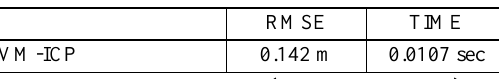
Table 7. VM-ICP Results (Second Experiment)